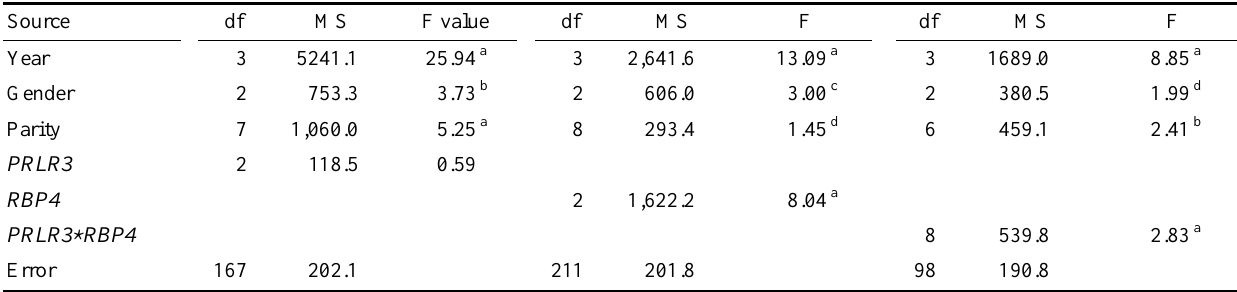
Table 5. Analysis of variance for days to 90 kg